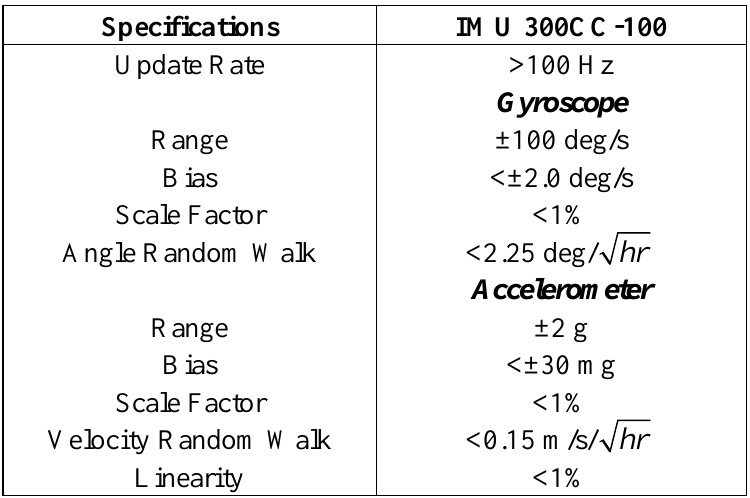
Table 1. Crossbow IMU